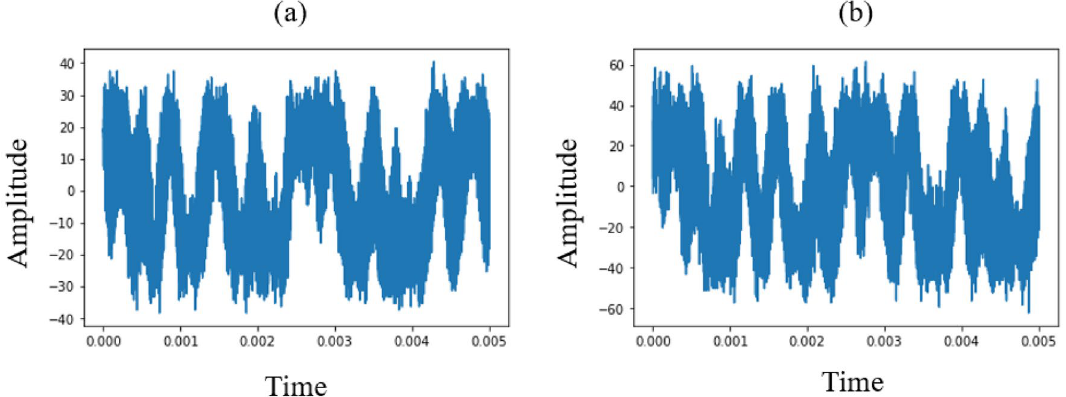
Figure 1. Time-domain envelopes of the WMT